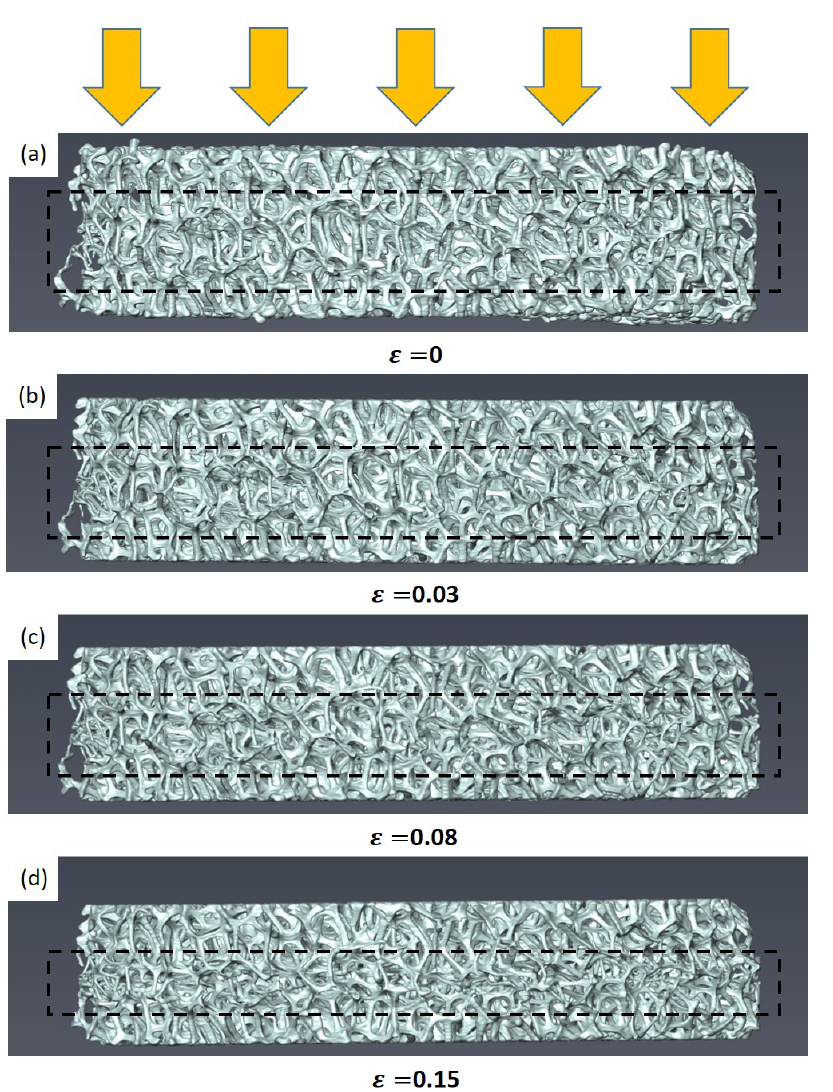
Figure 9. Observed microstructural evolution of the whole disc with strain during ex situ Figure 9: Observed microstructural evolution of the whole disc with strain during ex-situ compression